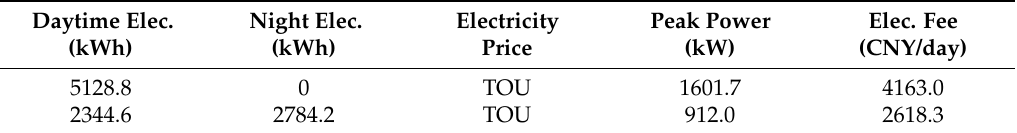
Table 8. The cost of different charging modes.